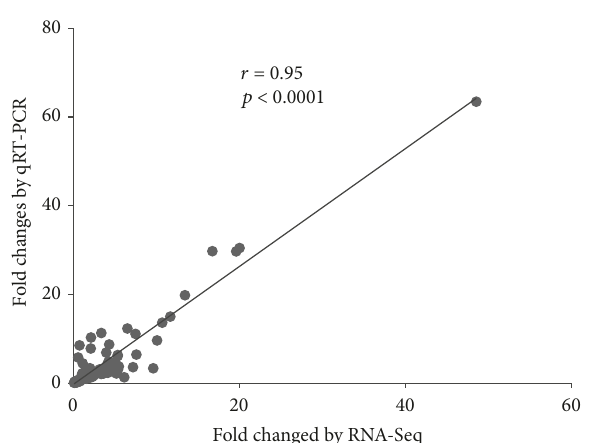
Figure 3: Correlation of gene fold changes between RNA- sequencing (RNA-Seq) and qRT-PCR